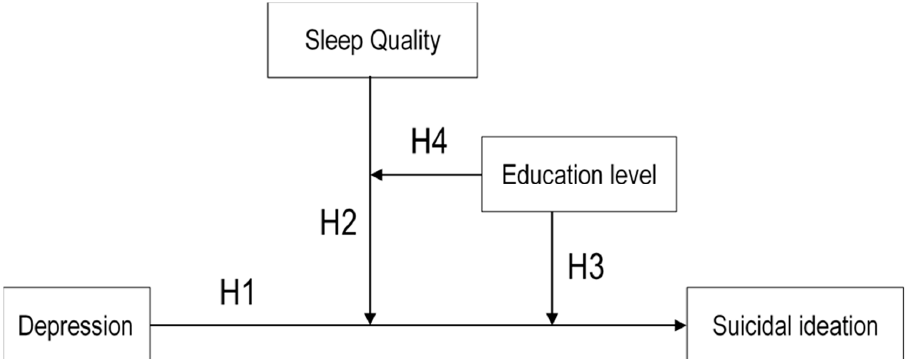
Figure 1. Conceptual framework. H, hypotheses.